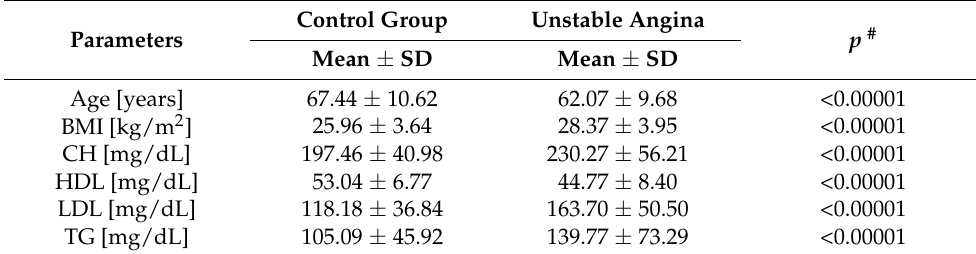
Table 1. Clinical characteristics of patients and control